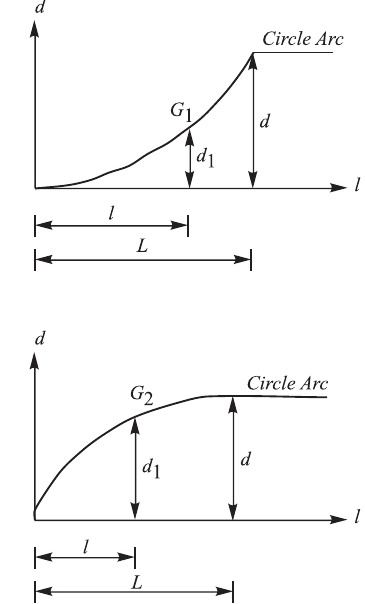
Fig. 4. The change of the